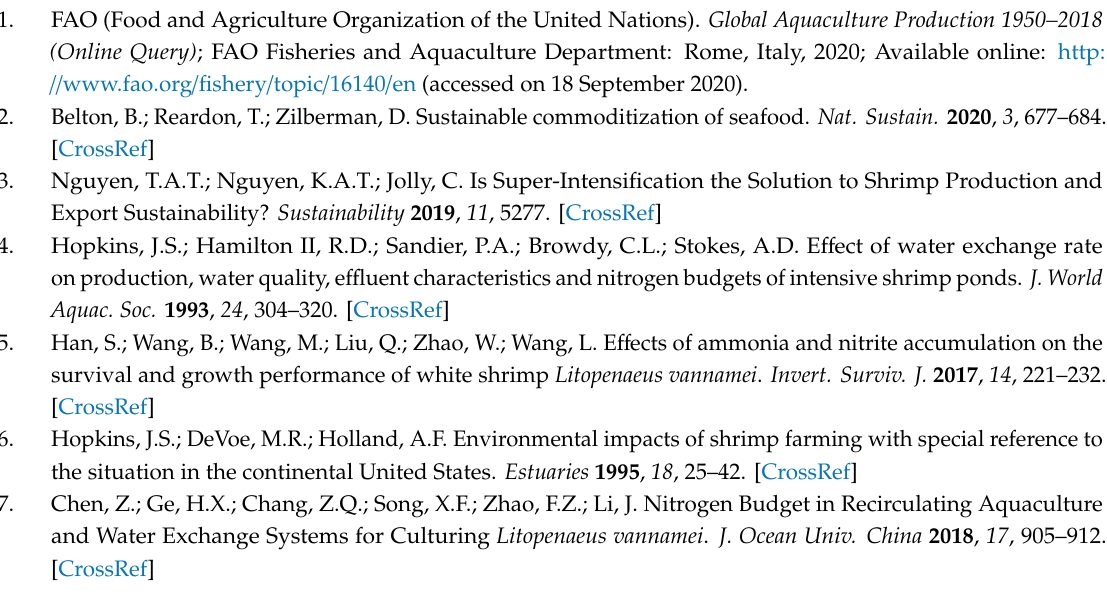
Table S1: The main water quality characteristics of the shrimp nursery